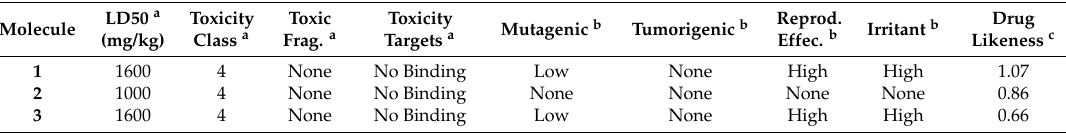
Table 4. Toxicological profile of PTP1B